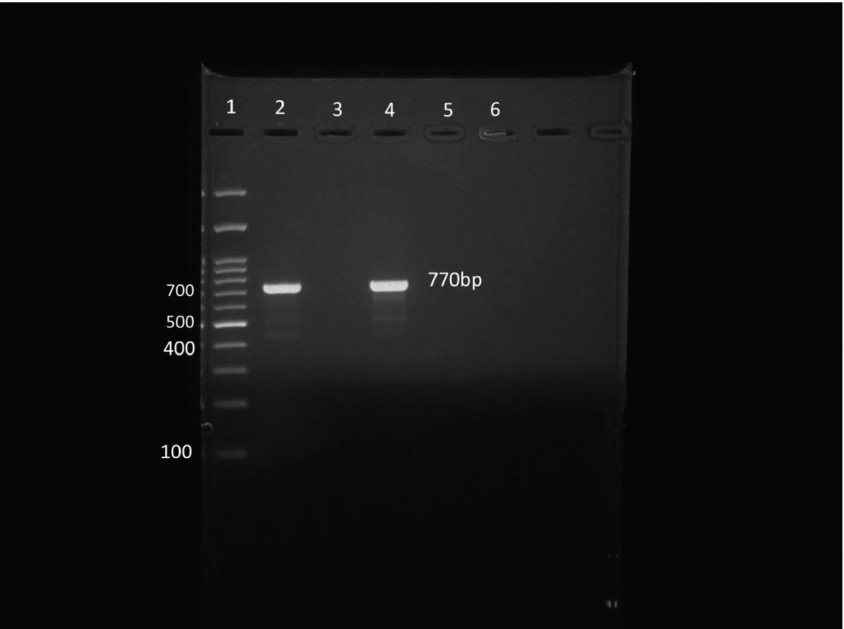
Figure 2: Gel electrophoresis picture of multiplex PCR, showing the positive band for serotype Ib. ∗ Lane 1: ladder 100bp; lanes 2 and 4: positive samples for serotype Ib; lanes 3, 5, and 6: negative samples.